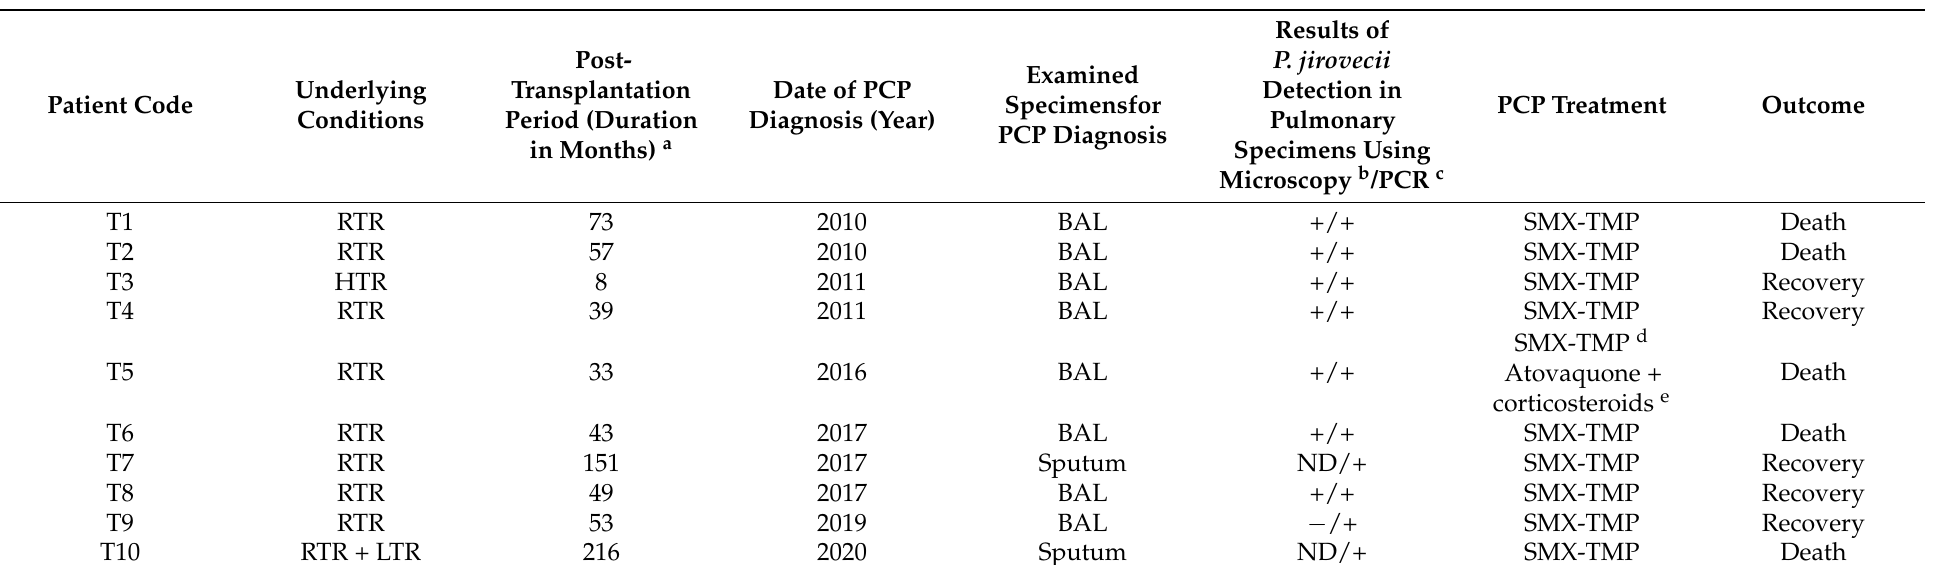
Table 1. Characteristics of the 10 solid organ transplant recipients treated with mycophenolic